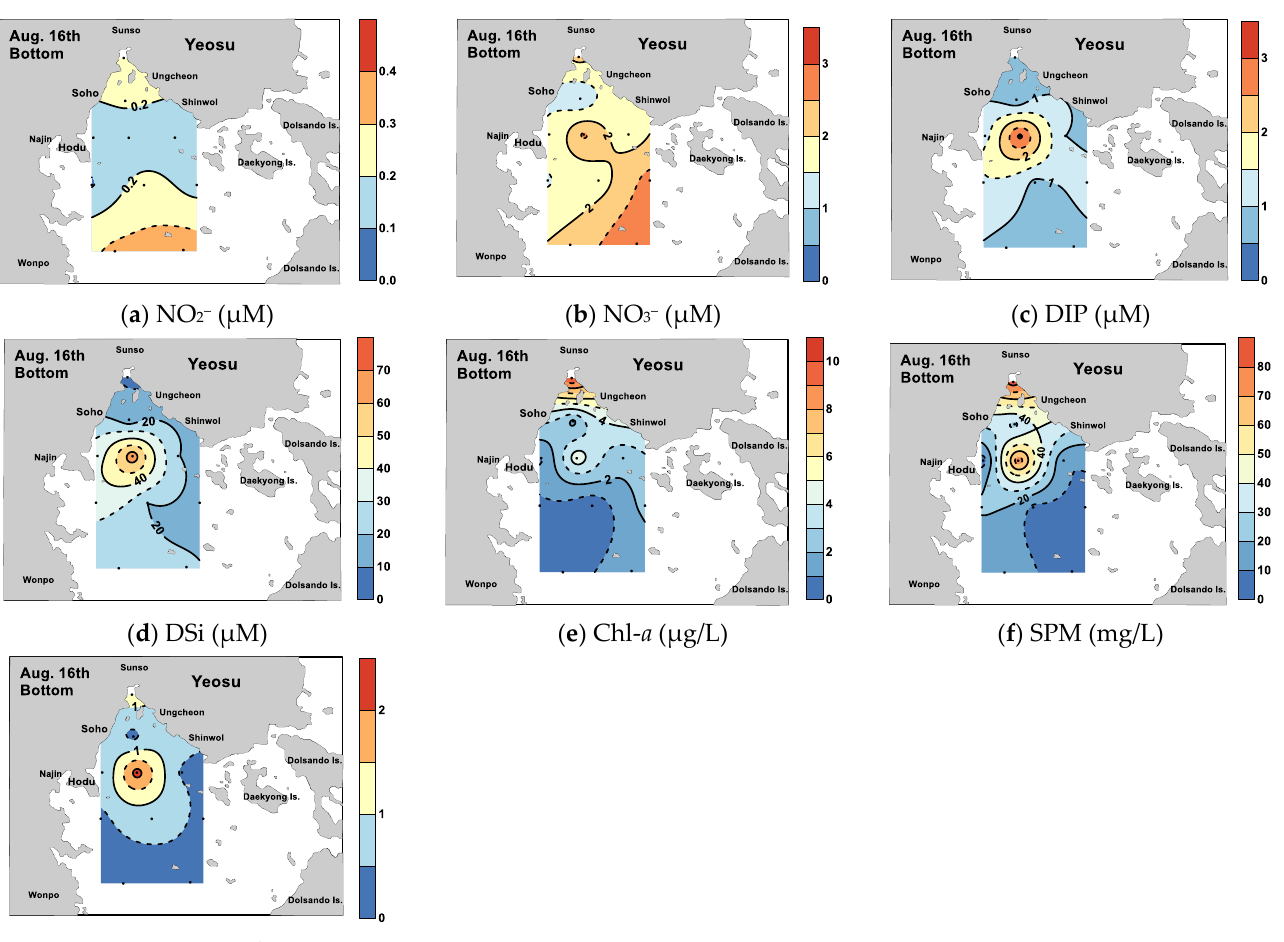
Figure 3. The spatial distributions of bottom seawater quality parameters, in Gamak Bay, Korea, in August 2017, ( a ) Water temperature (WT); ( b ) Salinity (SAL); ( c ) pH; ( d ) Dissolved oxygen (DO); ( e ) Hydrogen sulfide (H 2 S); ( f ) Ammonium-nitrogen (NH 4+ ).